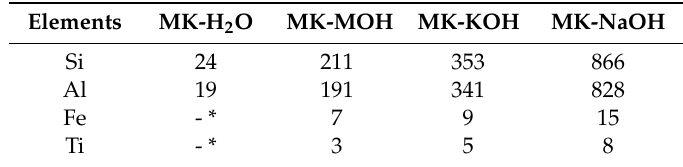
Table 6. Ion content [mg] of the filtrate measured with ICP-OES (after the experiment of 5 g sample in 400 mL solution).